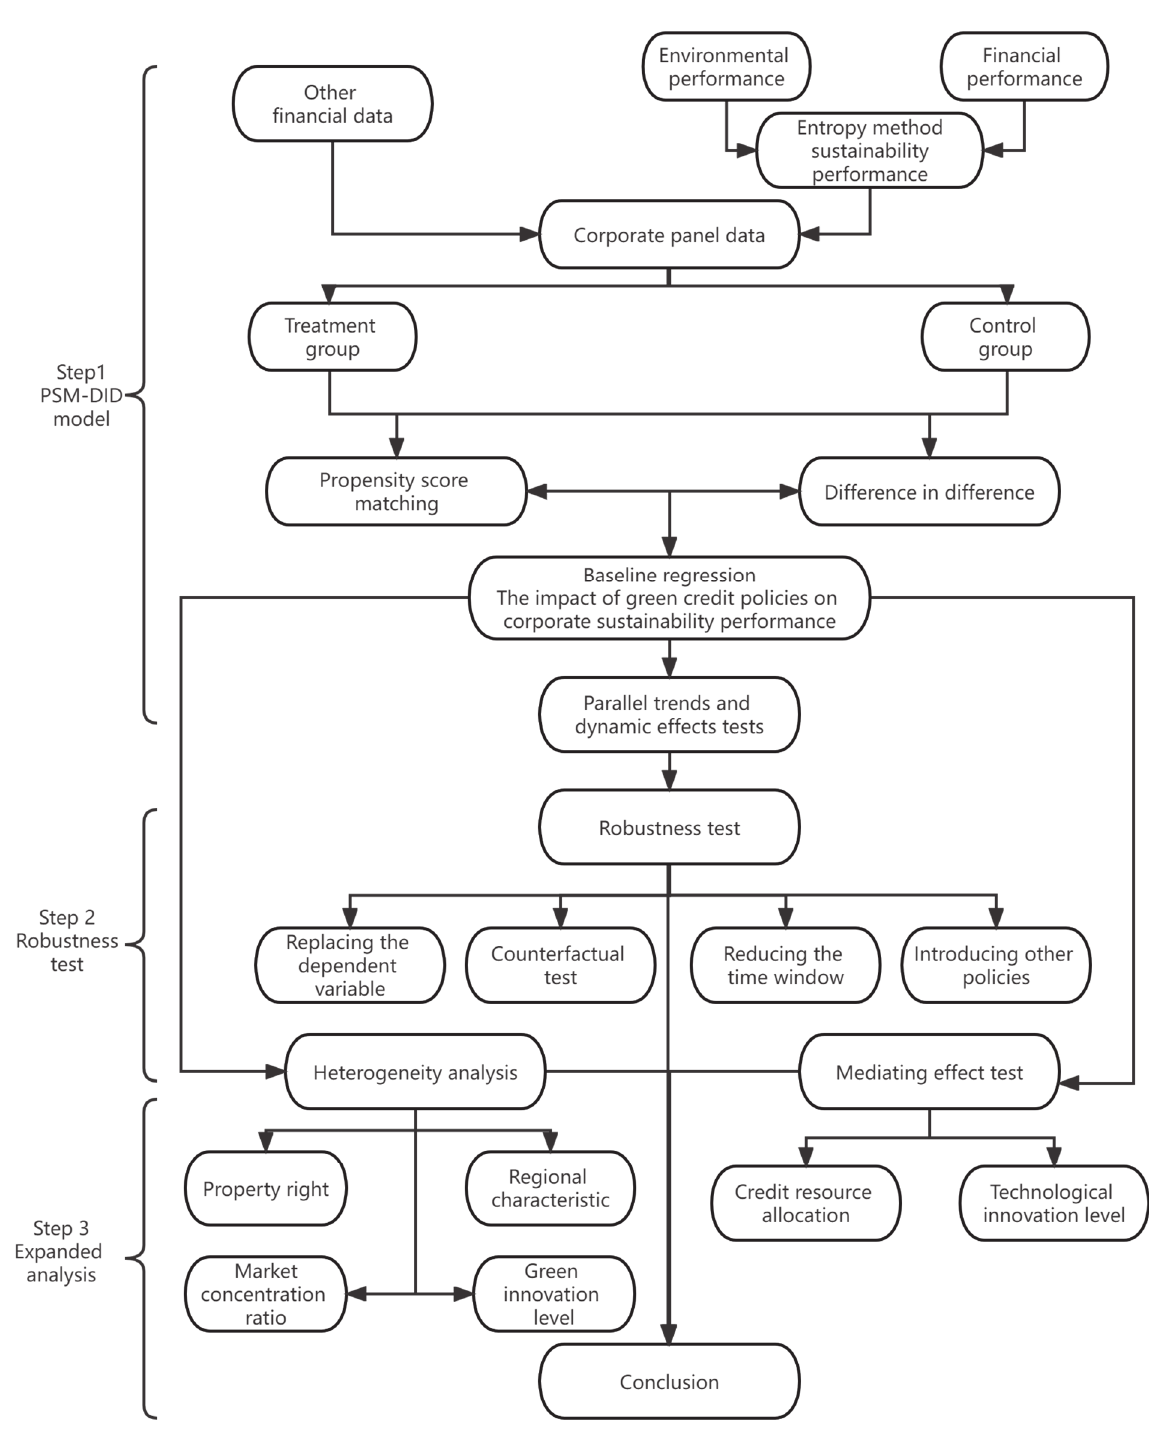
Figure 2. Structure of an integrated model for the impact of GCP on CSP.